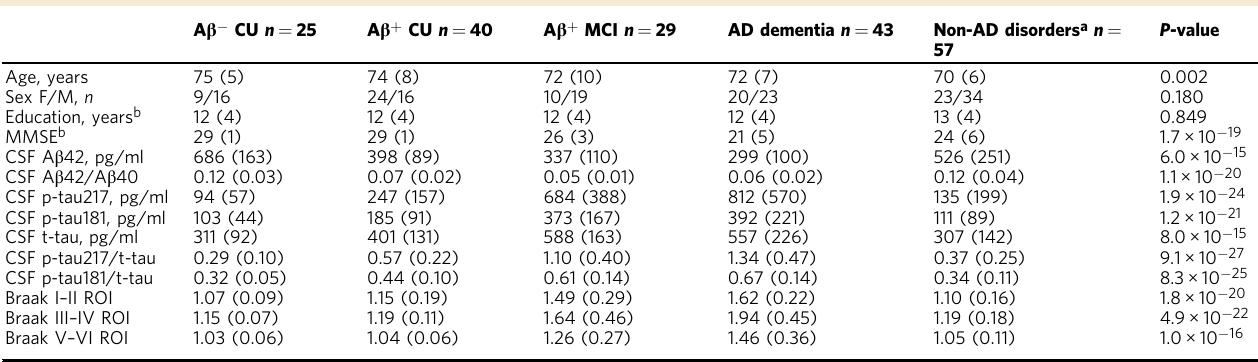
Table 1 Demographic and clinical